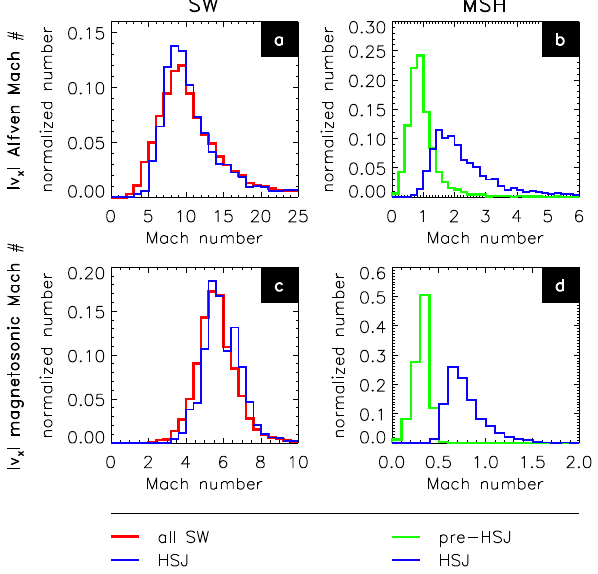
Fig. 6. Distributions of solar wind (SW) and magnetosheath (MSH) data for all sheath intervals, HSJs, and pre-HSJ times: rows (top and bottom) correspond to Alfvén and magnetosonic Mach numbers computed from GSE x direction ion velocity moments only. Left column: distributions of OMNI solar wind data corresponding to all times for which magnetosheath measurements are available (red), as well as solar wind data corresponding to HSJ t 0 times only (blue). Right column: distributions of THEMIS sheath data corresponding to HSJ t 0 times (blue) as well as to pre-HSJ intervals (green).